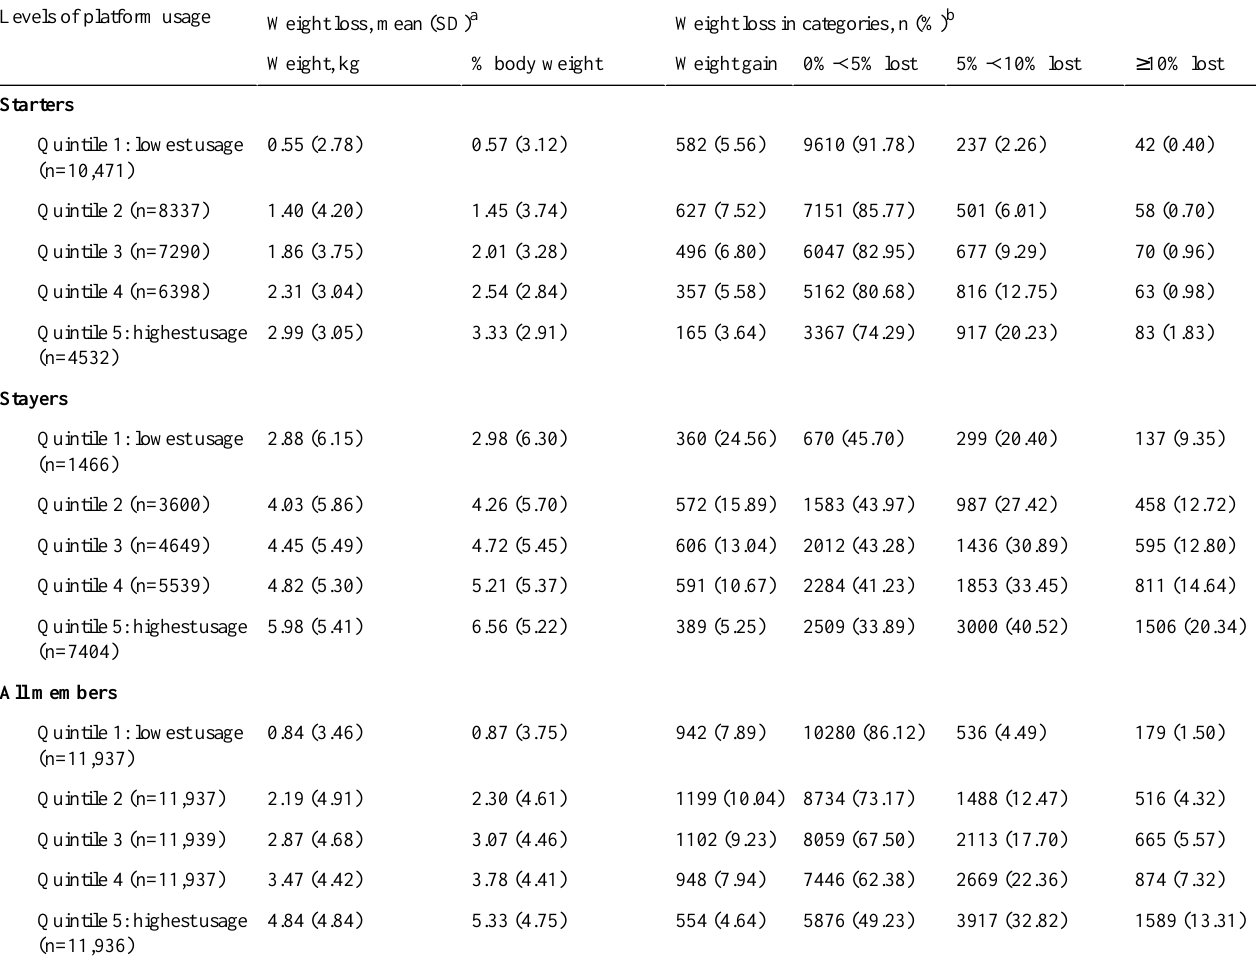
Table 6. Weight loss by level of platform usage for starters (n=37,028), stayers (n=22,658), and all members (N=59,686) in the CSIRO Total Wellbeing Diet Online.